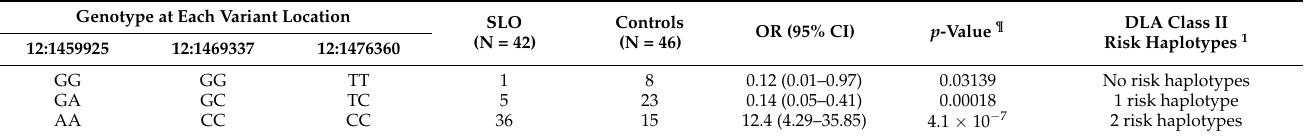
Table 2. Genotypes at each of the three missense variants predicted to be deleterious in TNXB for Bearded Collies and the type of DLA class II haplotypes (i.e., risk haplotype or non-risk haplotype for SLO) associated with those TNXB variant combinations. Variant locations are based on the CanFam3.1 reference genome. Genotype at Each Variant